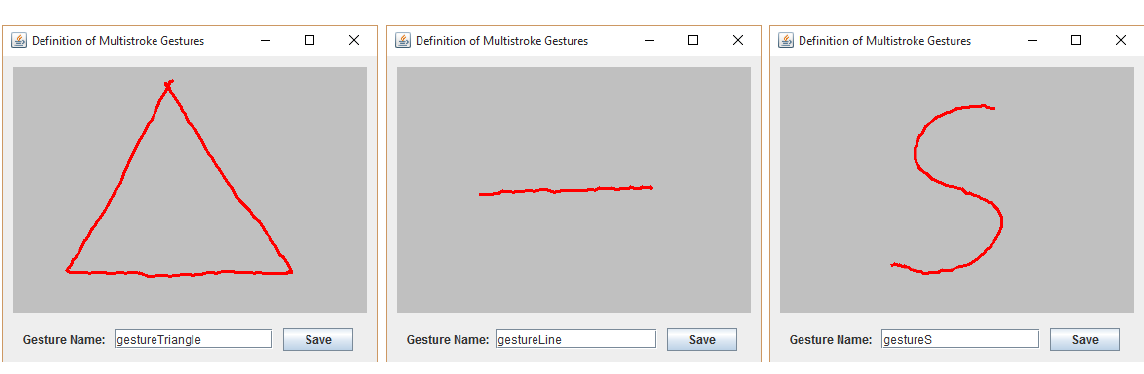
Figure 13. Gesture catalogue defined by